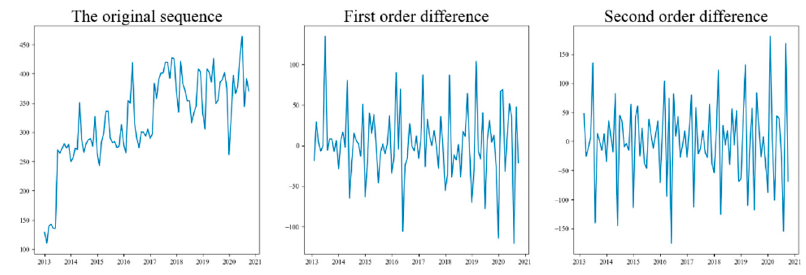
Figure 6. Sequence after differential treatment.